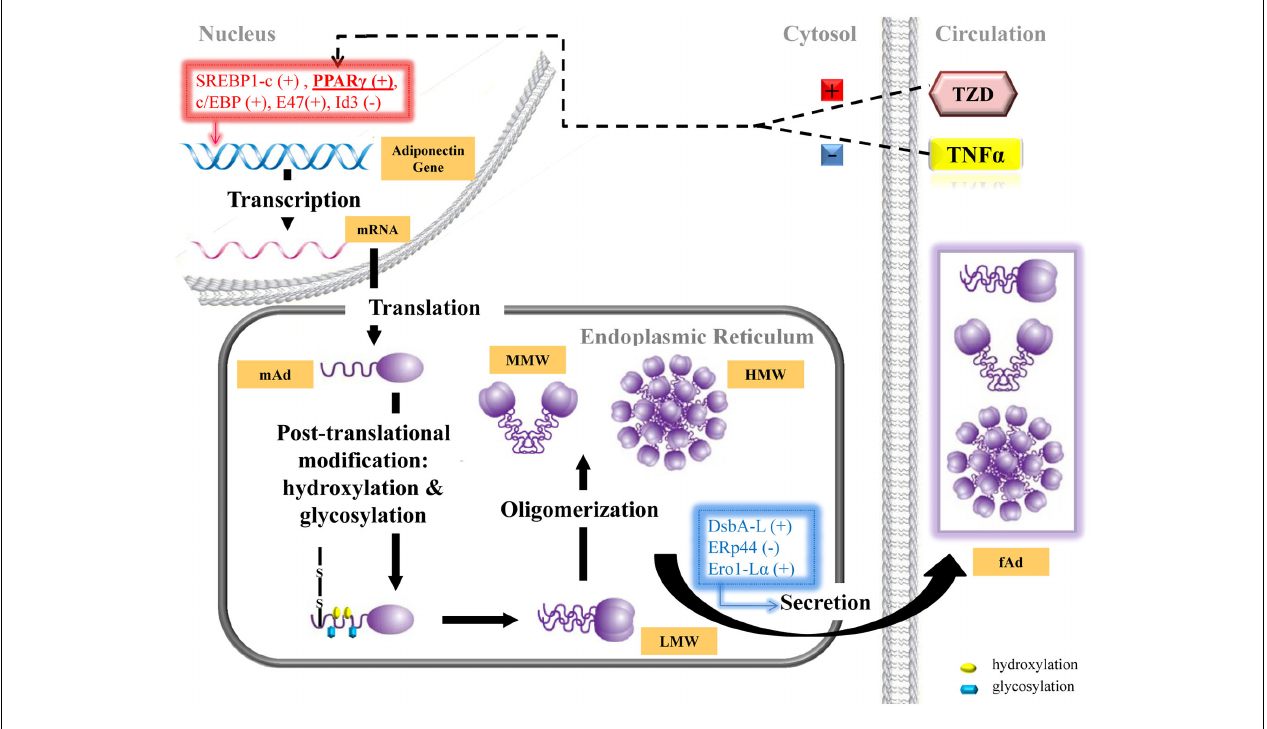
TNF- α ) adiponectin expression. Monomeric adiponectin (mAd) is posttranslationally modified and further oligomerized to form trimers (low molecular weight, LMW), hexamers (medium, MMW) and oligomeric (high, HMW) forms.Various mechanisms (bottom right) mediate this oligomerization and secretion resulting in secretion of HMW, MMW, and LMW